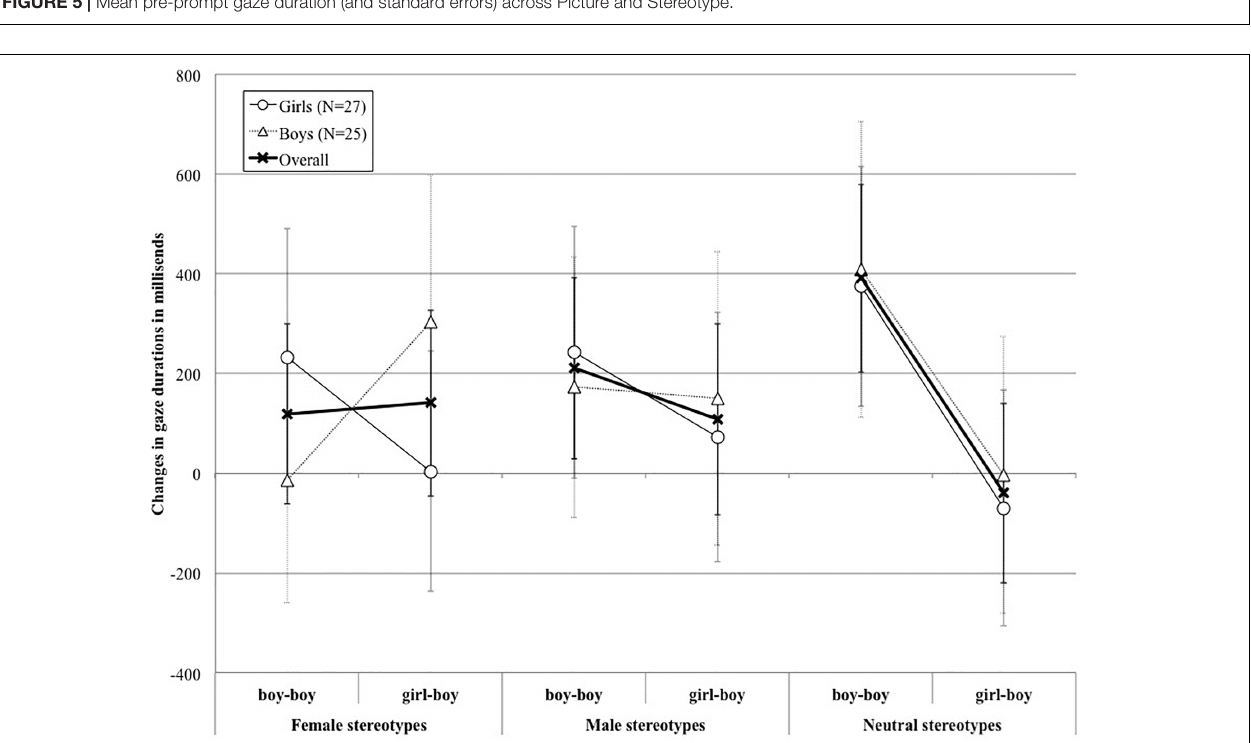
FIGURE 6 | Mean pre-post prompt changes (and standard errors) in gaze durations across conditions. Positive times mean more gazes at the post-prompt phase.